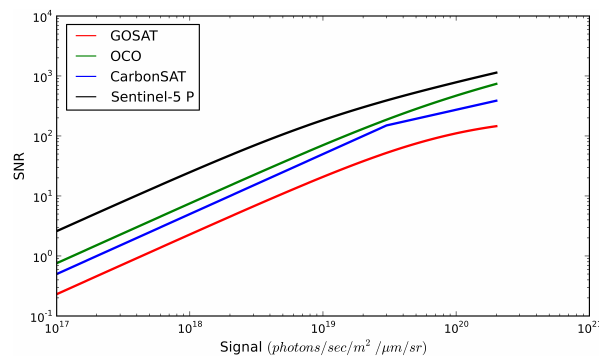
Figure 2. Assumed signal-to-noise (SNR) models for the four in- struments GOSAT, OCO-2, CarbonSat and S-5